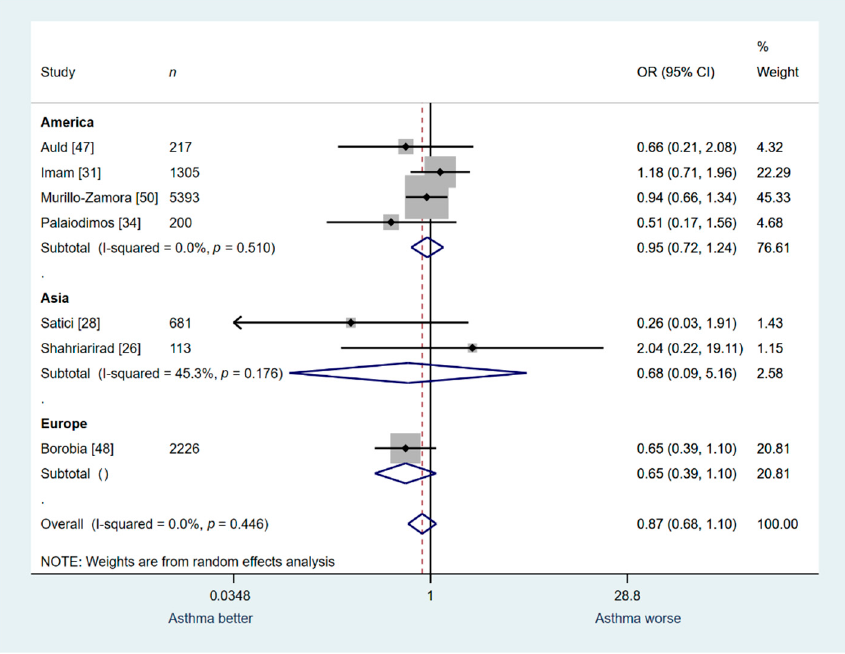
Figure 7. Overall analysis: asthma vs. no asthma for in ‐ hospital mortality.